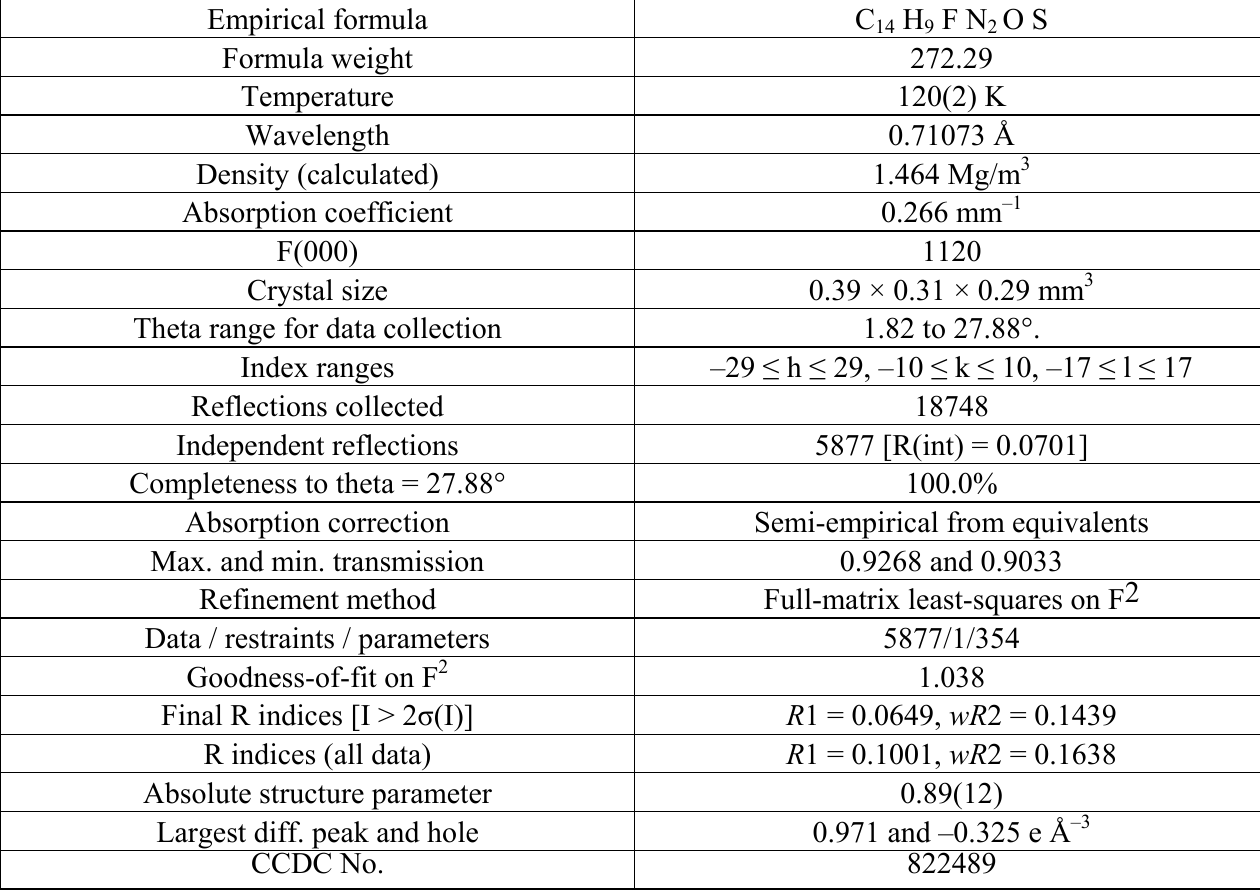
Table 1. Crystal data and structure refinement for ( 2